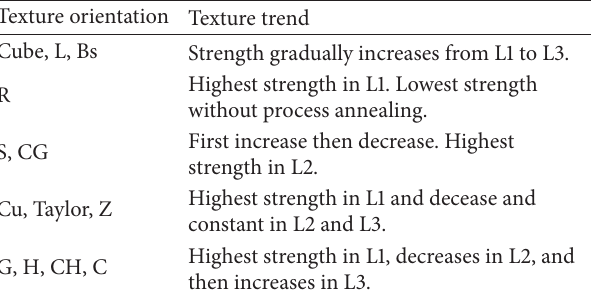
Table 3: Texture trend of final annealed gauge (from L1 to L3). Texture orientation Texture